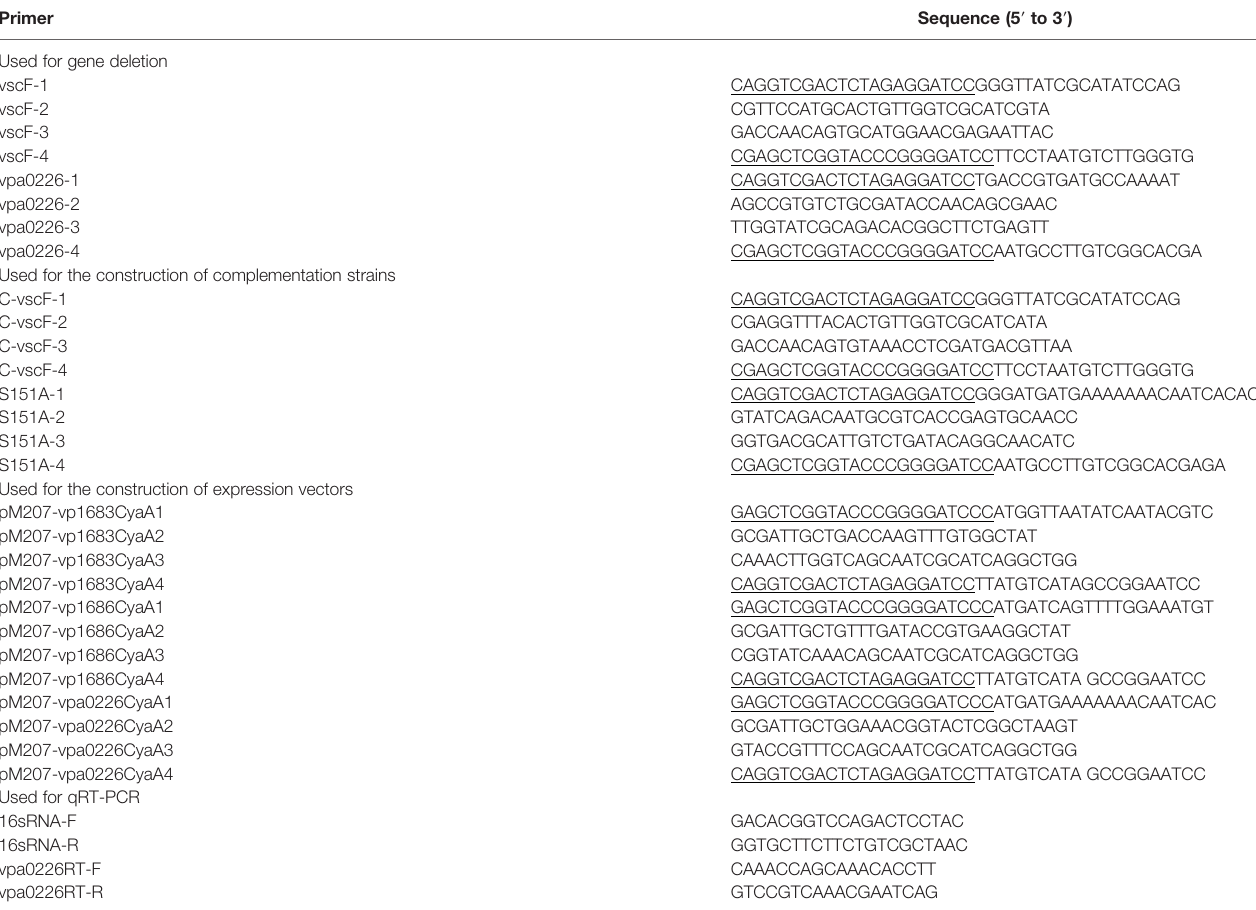
TABLE 2 | Sequences of the primers used for the construction of mutants and expression